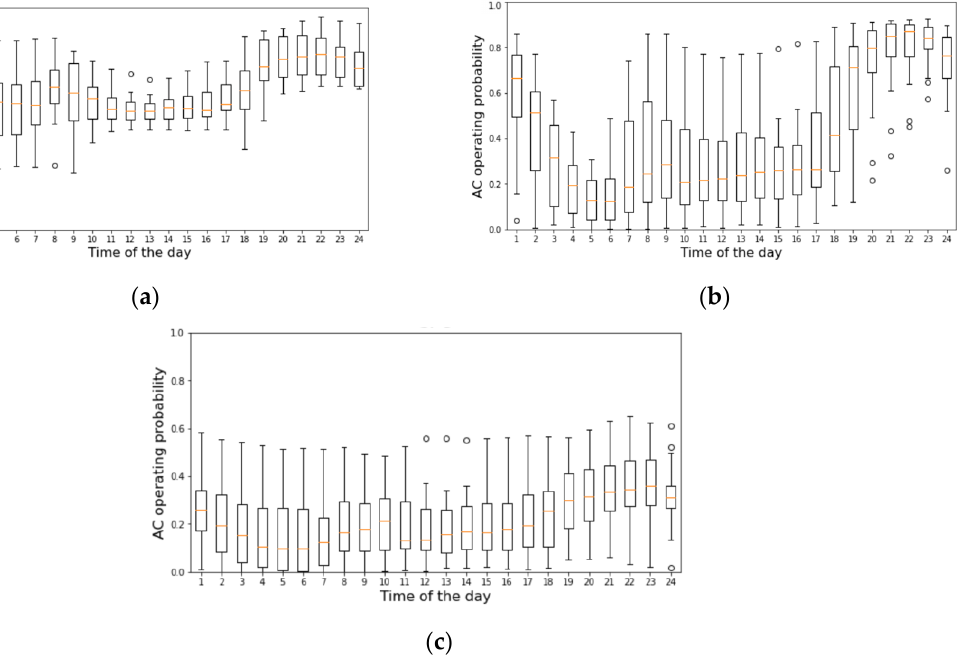
Figure 7. Box plot of AC operating probabilities for three clusters. ( a ) Schedule Preference A (SPA). ( b ) Schedule Preference B (SPB). ( c ) Schedule Preference C (SPC).